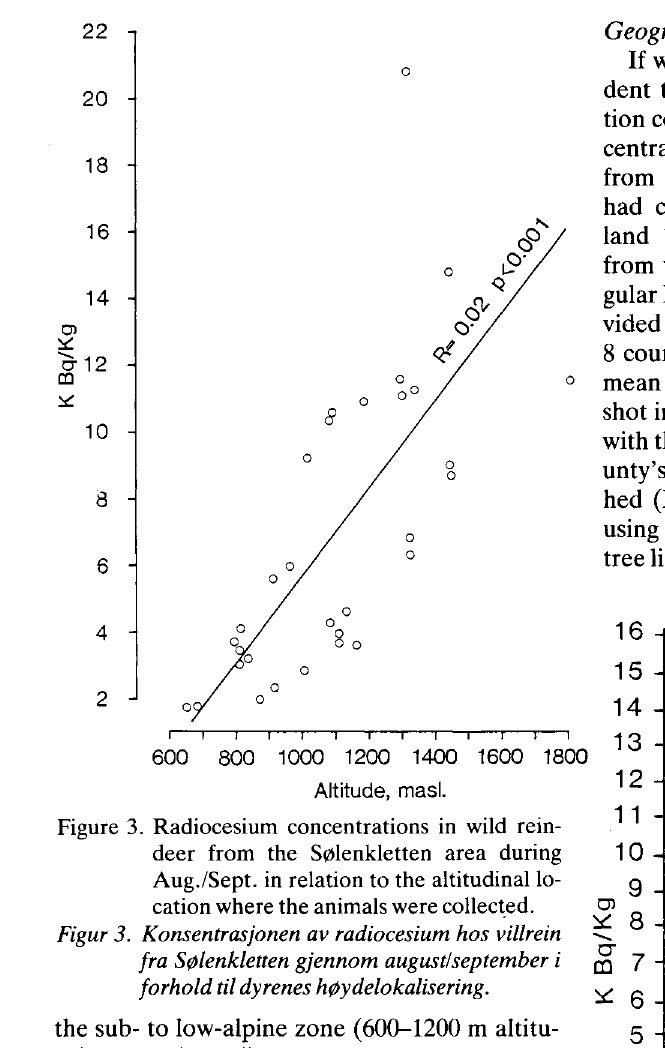
Figure 3. Radiocesium concentrations in wild rein deer from the S0lenkletten area during Aug./Sept. in relation to the altitudinal lo cation where the animals were collected. Figur 3. Konsentrasjonen av radiocesium hos villrein fra S0lenkletten gjennom augustlSeptember i forhold til dyrenes h0ydelokalisering.